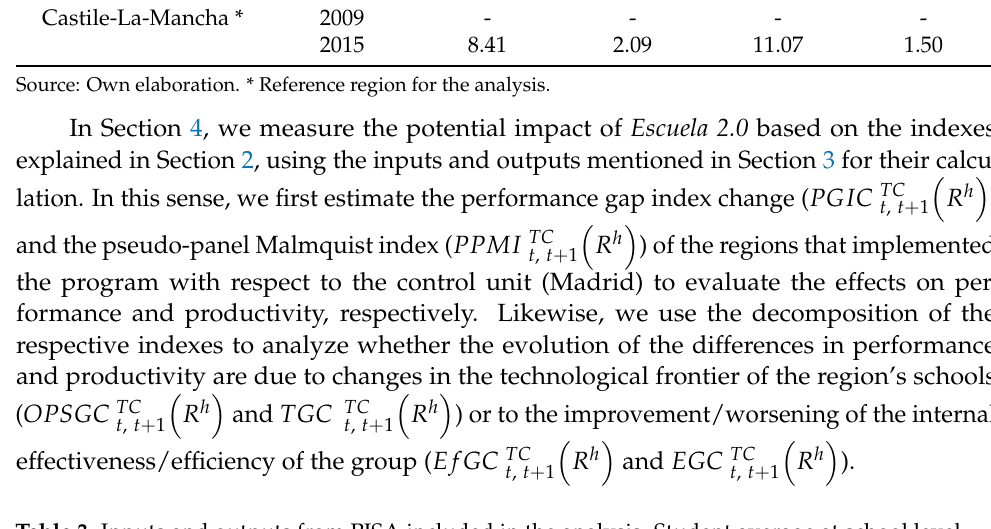
Table 3. Inputs and outputs from PISA included in the analysis. Student average at school level. Variable Description MATHS Test score in